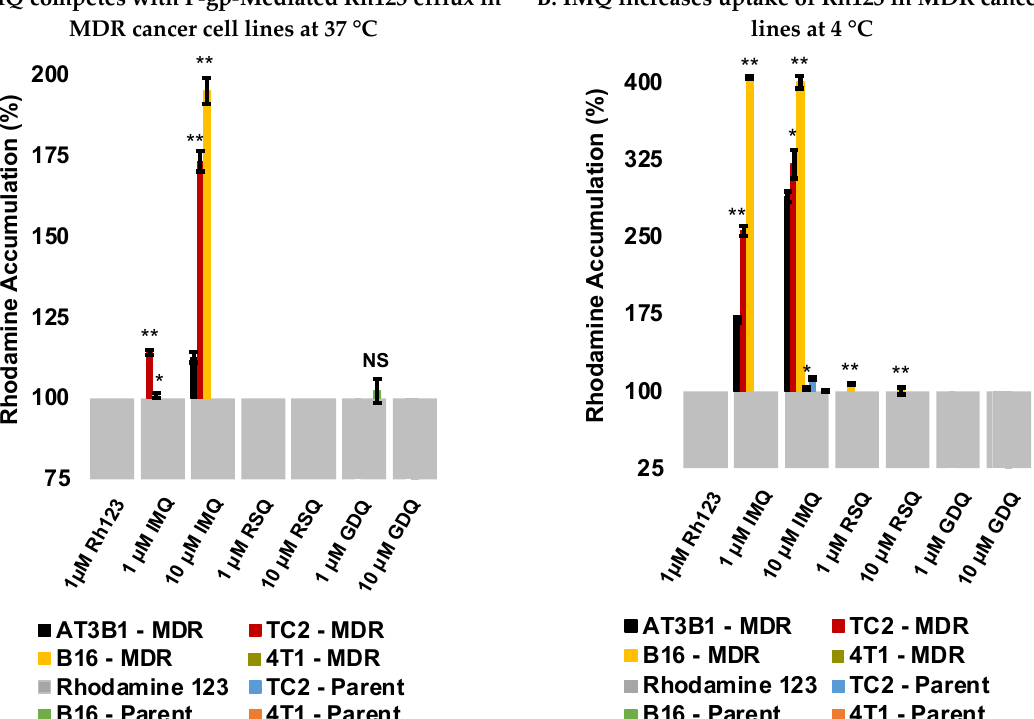
Figure 4. ( A ) Competitive experiments performed at 37 °C with P-gp substrate Rh123. IMQ leads to an increase in Rh123 accumulation in MDR-derived cancer cells under active transport conditions. Data representative of triplicate experiments. ( B ) Uptake experiments performed at 4 °C with P-gp substrate, Rhodamine 123. IMQ leads to an increase in Rh123 accumulation in MDR-derived cancer cells under passive diffusion conditions. Data representative of triplicate experiments. p -values were calculated between parent vs. MDR cancer cell type with * p < 0.01, ** p < 0.001 and NS: Not